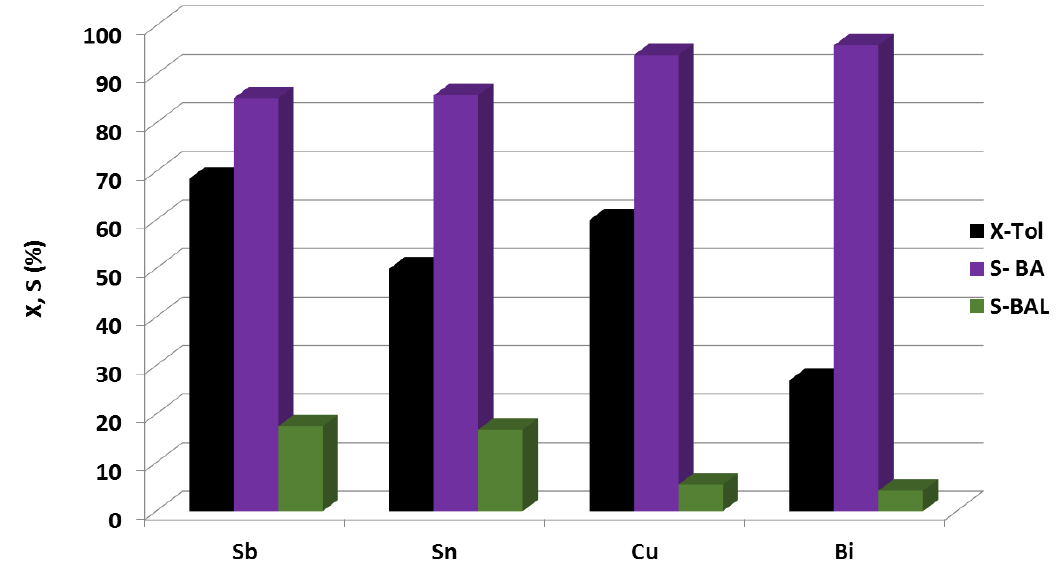
Figure 5. Effect of promoter on the catalytic performance of 10% Pd ‐ 8% Sb/TiO 2 catalyst. (Reaction conditions: Tol:AcOH:O 2 (air):Ar = 1:4:3(15):4; GHSV = 2688 h − 1 ; τ = 1.34 s; T = 210 °C; P = 2 bar).